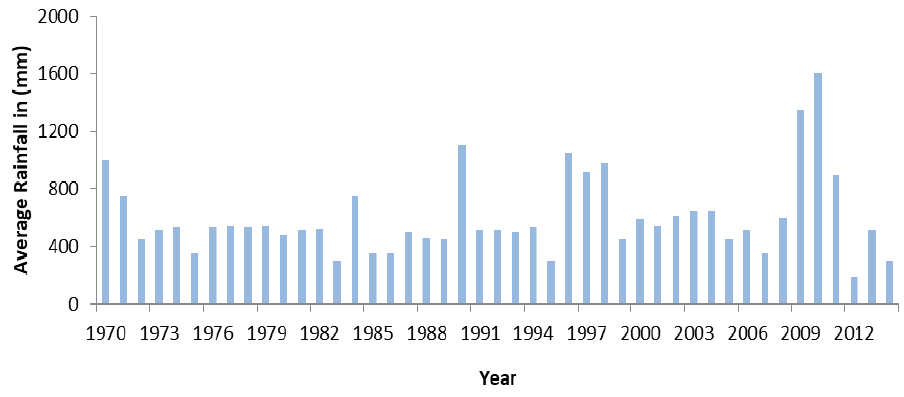
Figure 2. Average annual precipitation in OLW (1970 – 2014) .